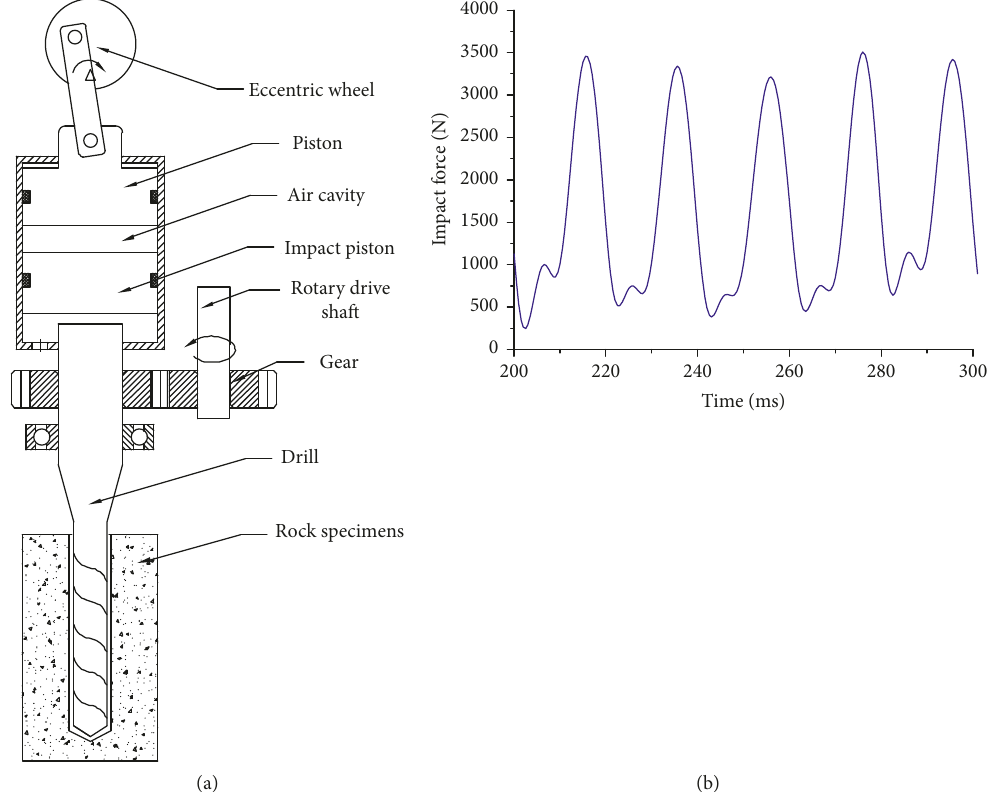
Figure 5: Principle of electric hammer’s drilling and implementation. (a) Schematic diagram of electric hammer’s drilling. (b) Waveform of electric hammer’s impact force.